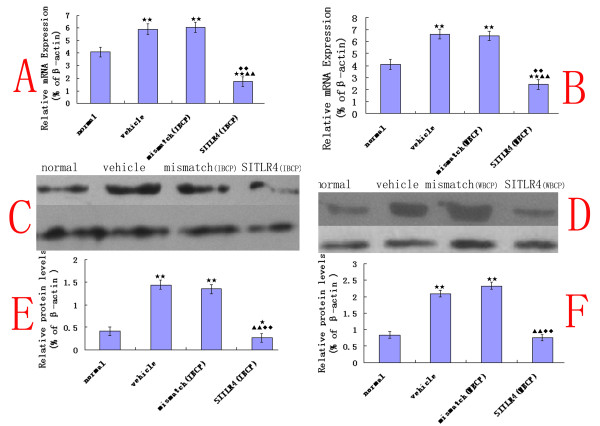
Attenuation of TLR4 expression by Intrathecal TLR4 siRNA439. (A, B) The TLR4 mRNA levels in the L4~6 lumbar spinal cord from mismatch siRNA- and vehicle- treated bone cancer pain rats were higher in IBCP group (A) and in WBCP group (B) (n = 4, ANOVA1w, P < 0.01, post hoc Dunnett testing, df = 3, F = 1.12)relative to that of normal rats. TLR4 siRNA439 (SITLR4) treatment caused a significant decrease in IBCP group, and in WBCP group in the TLR4 mRNA level compared with that in normal rats (P < 0.01). (C, D, E, F) Data from several western blotting experiments revealed a significant up-regulation of TLR4 (n = 4, ANOVA1w, P < 0.01, post hoc Dunnett testing, df = 3, F = 1.16) protein in mismatch siRNA-and vehicle- treated bone cancer pain rats relative to that from normal rats, whether in the IBCP group (C, E) or in the WBCP group (D, F). TLR4 siRNA439 treatment caused a significant decrease (n = 4, ANOVA1w, P < 0.01, post hoc Dunnett testing, df = 3, F = 0.96)relative the level in mismatch siRNA-and vehicle- treated bone cancer pain rats, and a significant decline compared to normal rats (P < 0.05) in the IBCP group (C, E). Values are presented as mean ± SEM. *P < 0.05, **P < 0.01 vs. normal group; ▲ P < 0.05, ▲▲ P < 0.01 vs. vehicle-treated group; ◆P < 0.05, ◆◆P < 0.01 vs. mismatch siRNA-treated group.